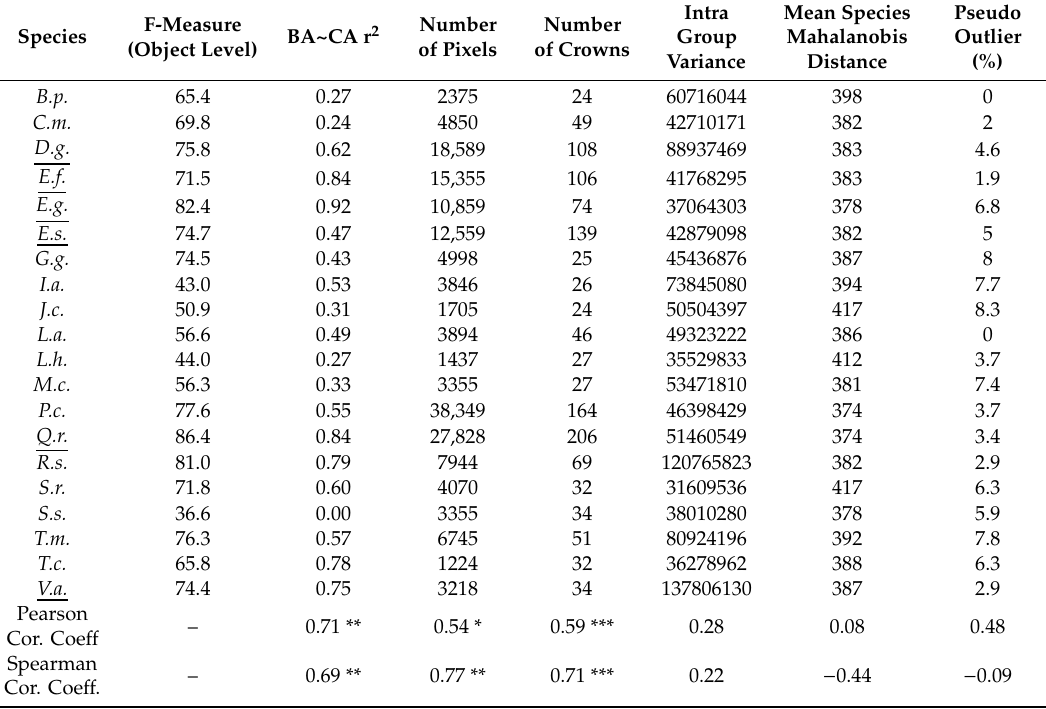
Table A5. F-measure and various metrics tested for